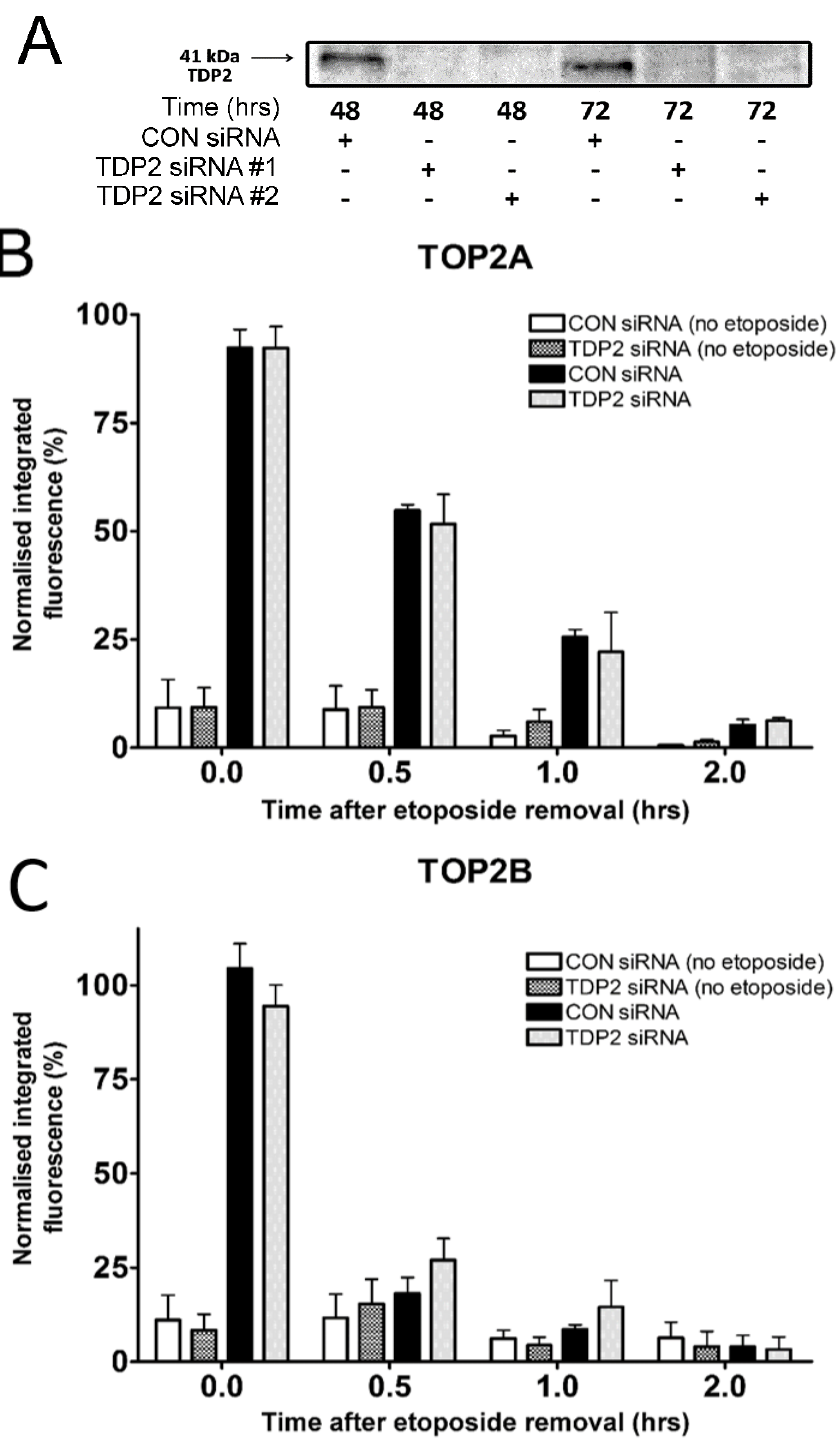
Figure 3. Cellular depletion of TDP2 does not affect topoisomerase II protein complex levels. TDP2 was depleted by two independent siRNAs. ( A ) Western blot visualising TDP2 protein levels after 48 and 72 h. ( B , C ) Cells transfected with 500 nM TDP2 siRNA #1 or non-coding (CON) siRNA were exposed to etoposide or solvent for 2 h and then placed in drug free media. TOP2A- and TOP2B-DNA complexes were quantified by TARDIS assay immediately after drug treatment and after 0.5, 1 and 2 h incubation in drug free media. Values are normalised to a 2 h 100 µM etoposide control ( n = 6).